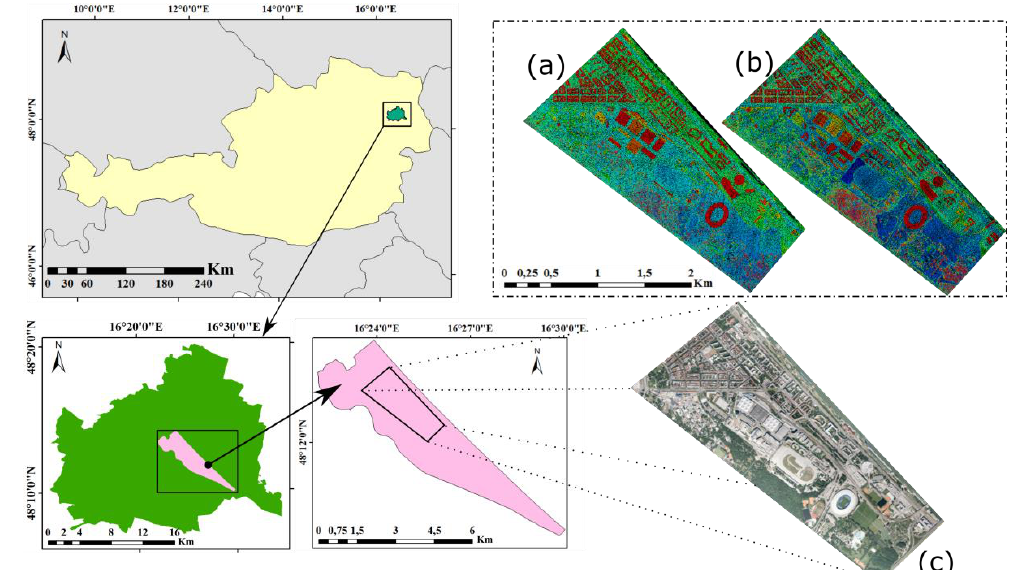
Figure 3. Experiment area: ( a ) LiDAR data for 2007; ( b ) LiDAR data for 2015; and ( c ) Google Earth image of experiment area.